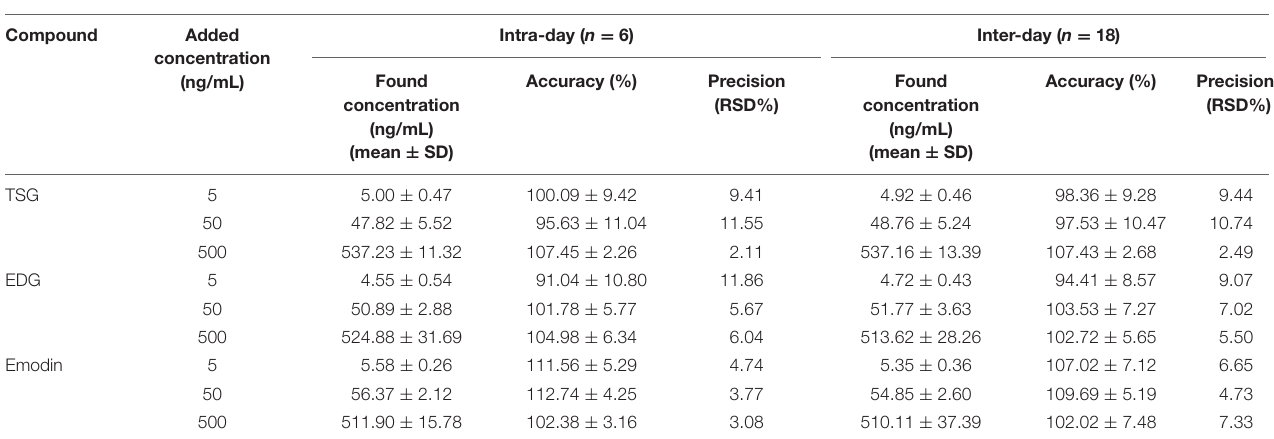
TABLE 3 | Accuracy and precision for the analysis of TSG, EDG and emodin in rat plasma.